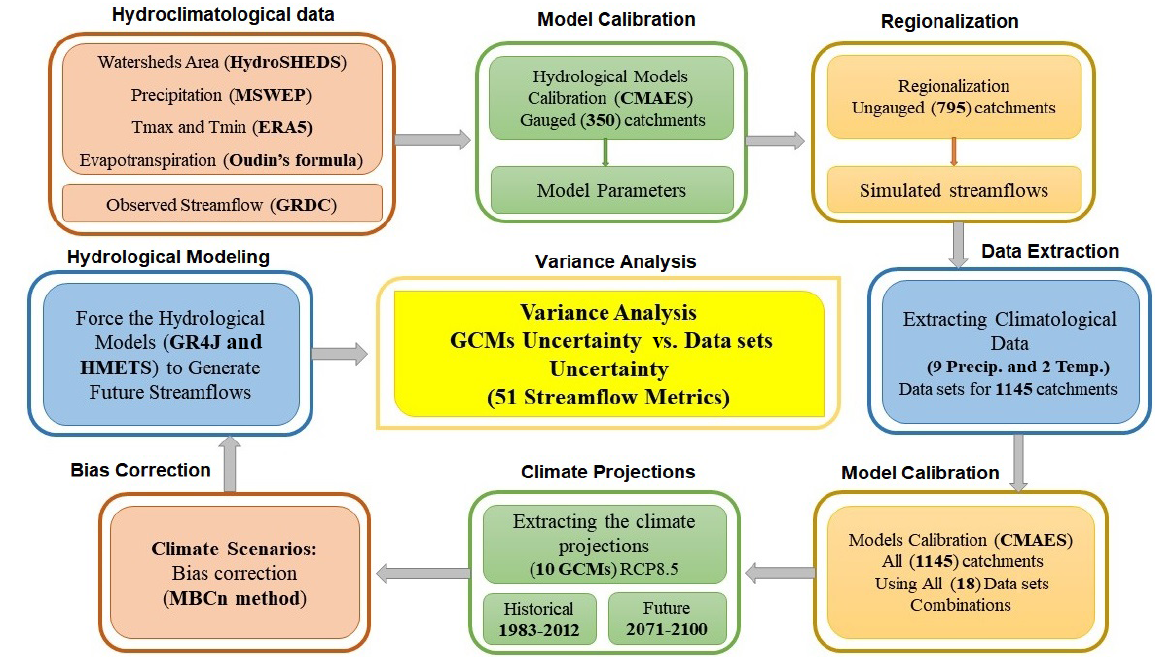
Figure 2. Overview of the various methodological steps implemented in this study.